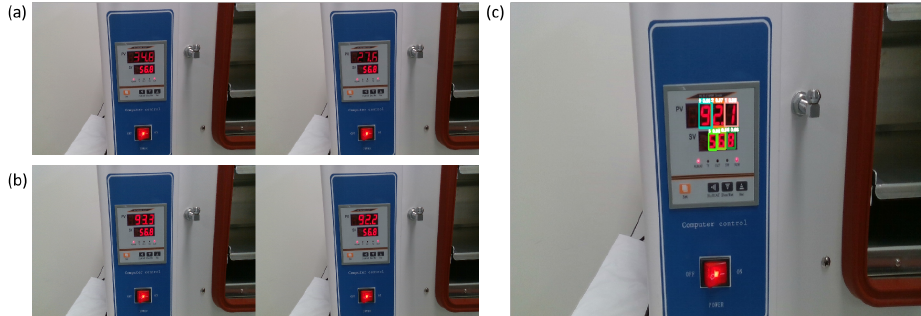
Figure 8. Detection example on migrating new scenarios. ( a ) FLIMM augmentation results. ( b ) Real images examples. ( c ) Improved YOLOv5 detection